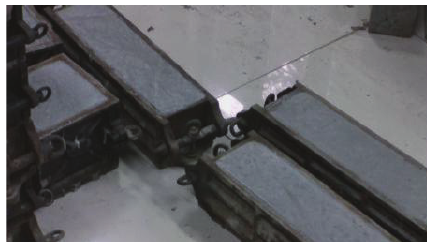
Figure 6: Concrete samples’ modeling procedure.